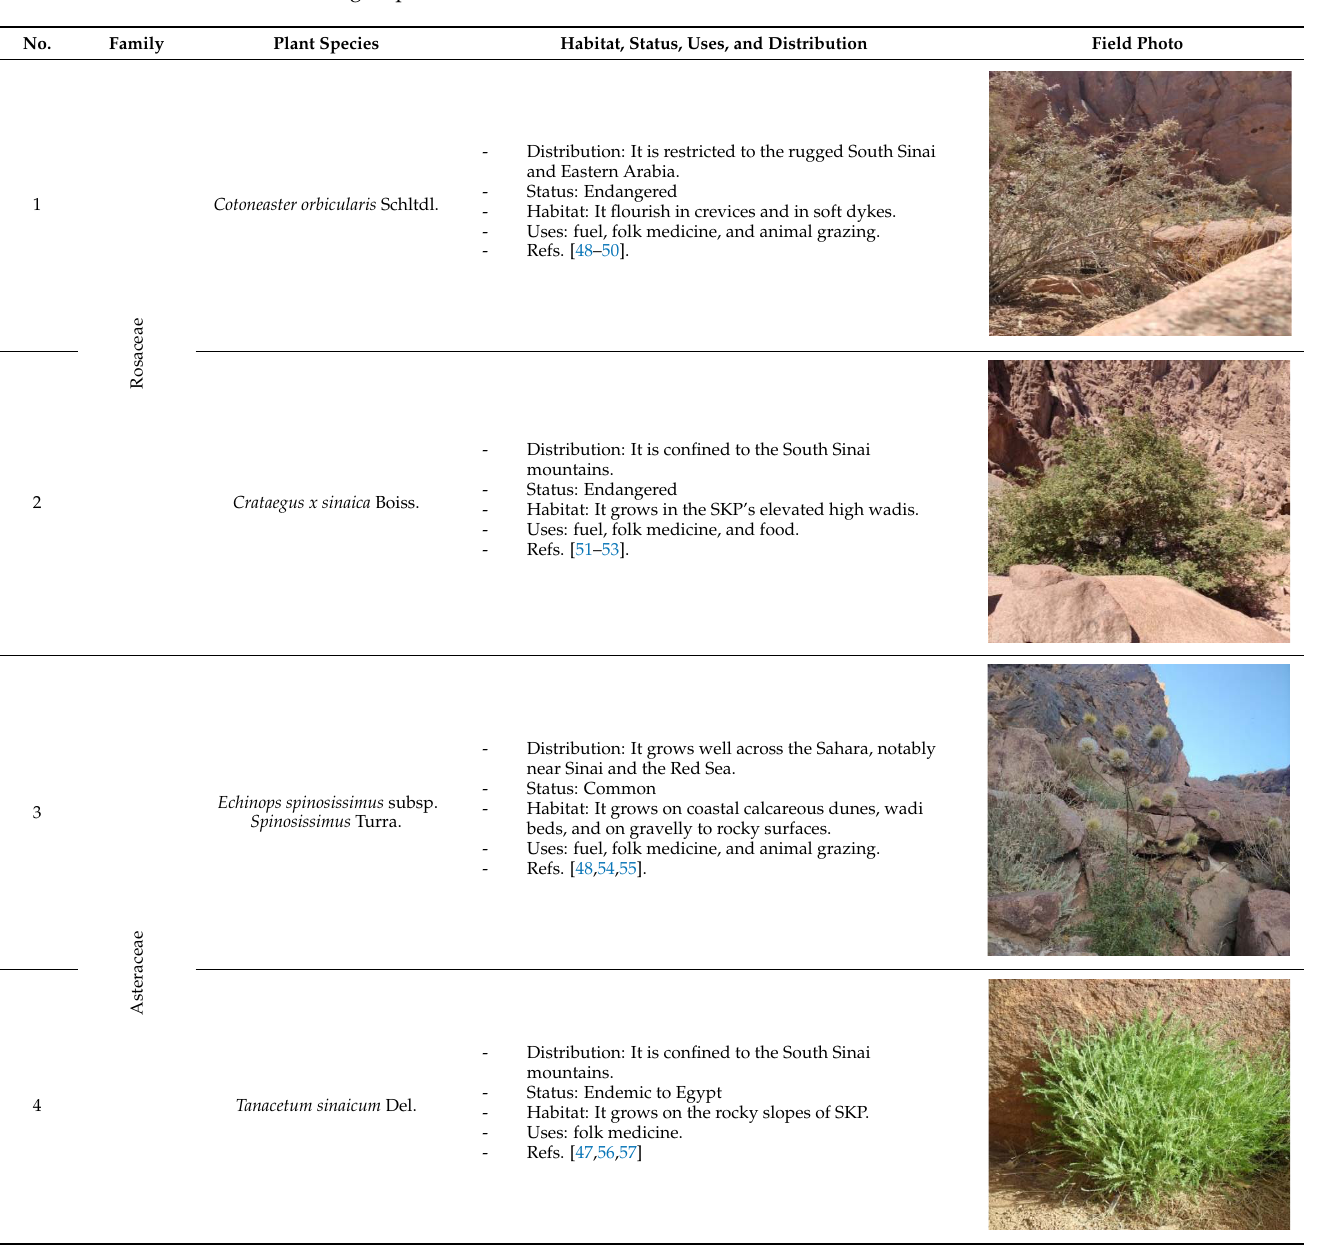
Table 1. Family, scientific name, habitat, status, uses, distribution, and field photos of the four target species.